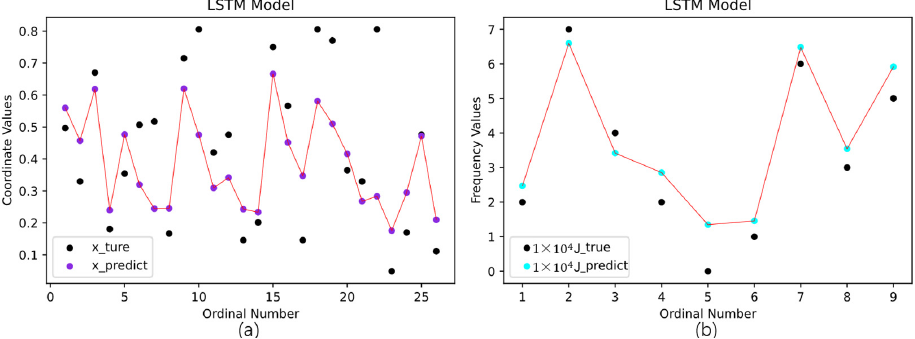
Figure 16. Prediction of LSTM model. ( a ) X coordinates of high-energy events. ( b ) Daily frequency corresponding to 10 4 J energy level